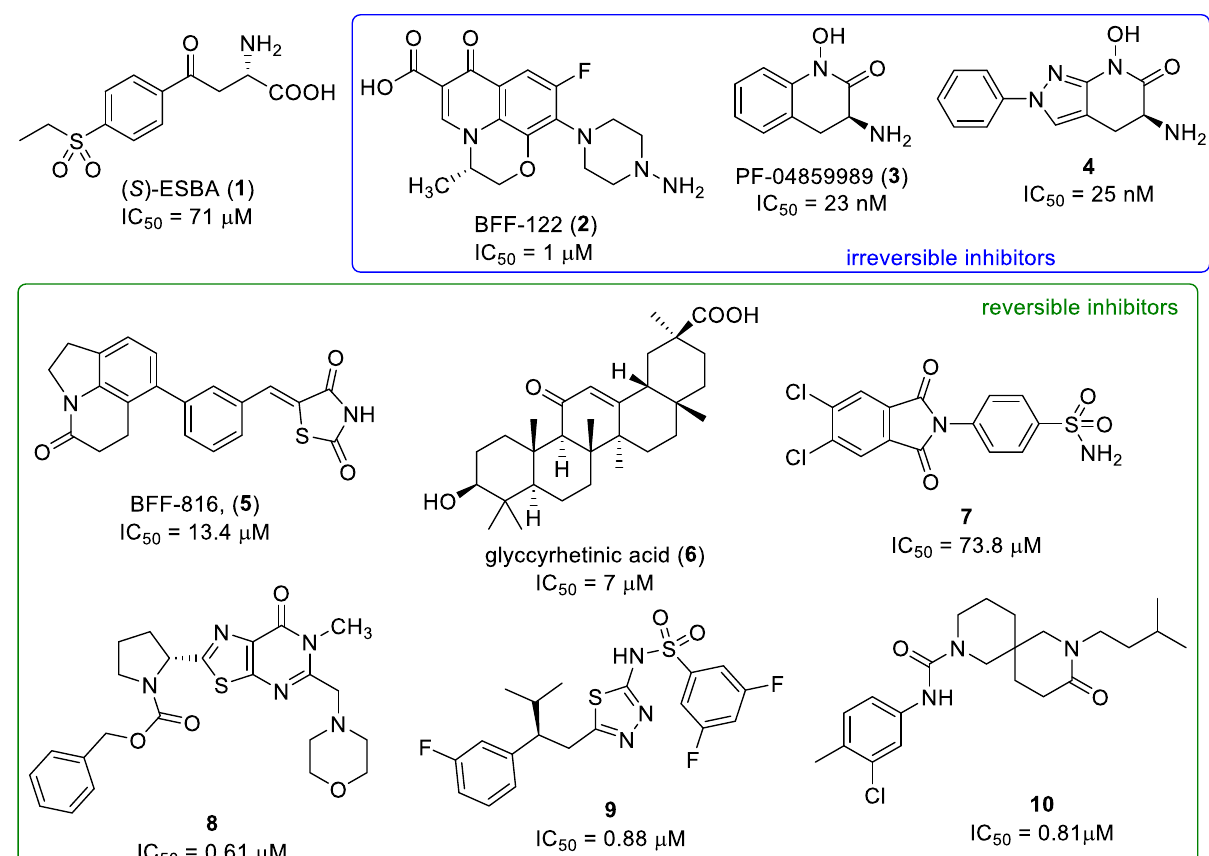
Figure 2. Examples of published KAT-II inhibitors.